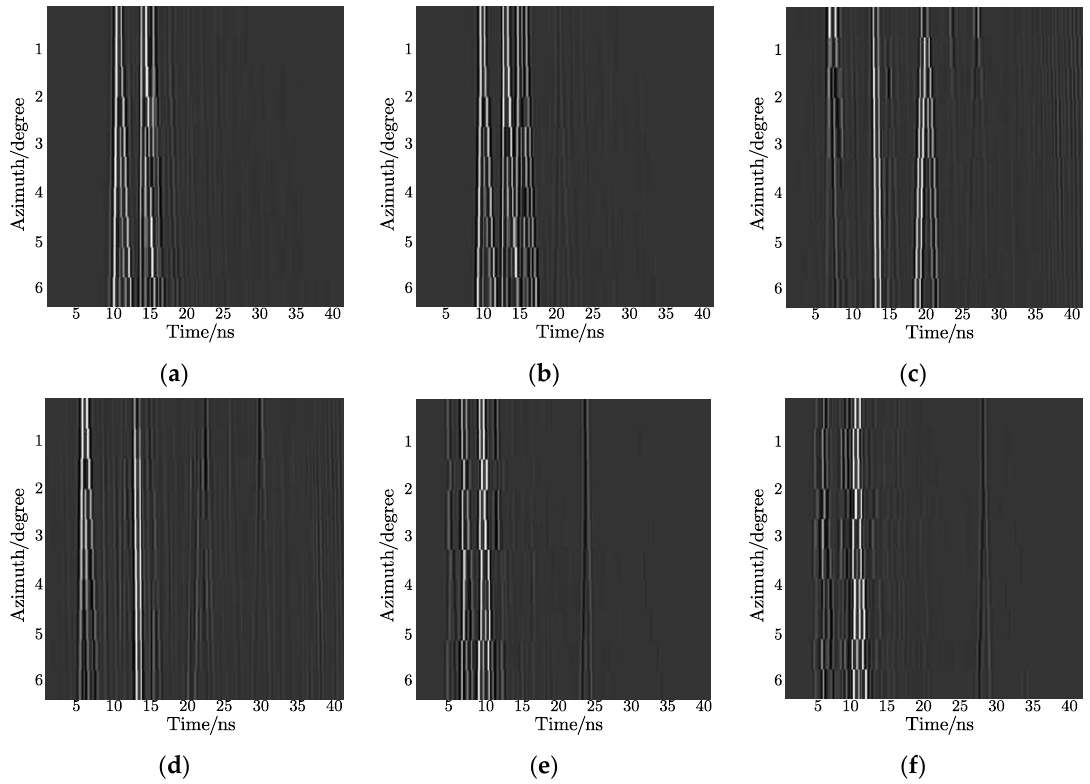
Figure 5. Geometric models: ( a ) wheeled vehicle with 25° azimuth; ( b ) wheeled vehicle with 30° azimuth; ( c ) tracked car with 25° azimuth; ( d ) tracked car with 30° azimuth; ( e ) box truck with 25° azimuth; ( f ) box truck with 30° azimuth.